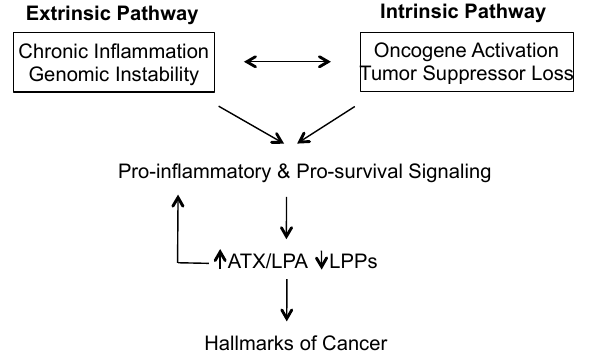
Figure 1. General overview of cancer initiation and the role of autotaxin/lysophosphatidate (ATX/LPA). A convergence of extrinsic and intrinsic pathways leads to sustained inflammatory and survival signaling that involves upregulation of ATX/LPA signaling through both increases in ATX and LPA concentrations with concurrent decreases in eco-lipid phosphate phosphatase (LPP)